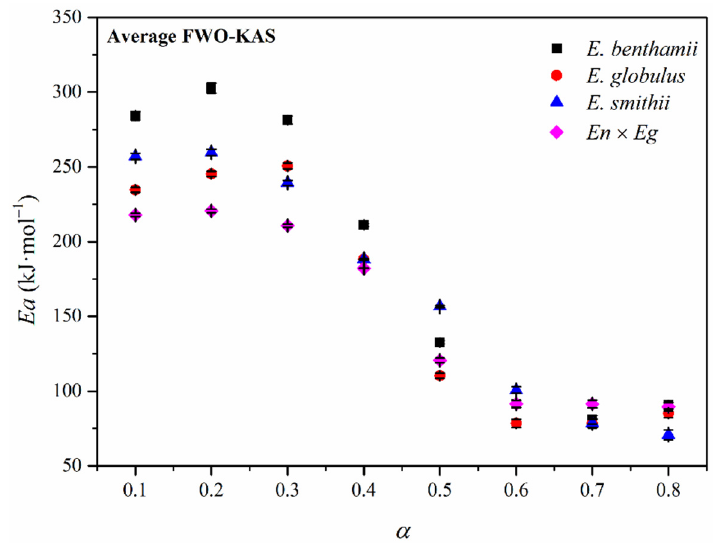
Figure 9. Evolution of the apparent activation energy ( Ea ) as a function of conversion calculated as an average for the FWO and KAS methods.